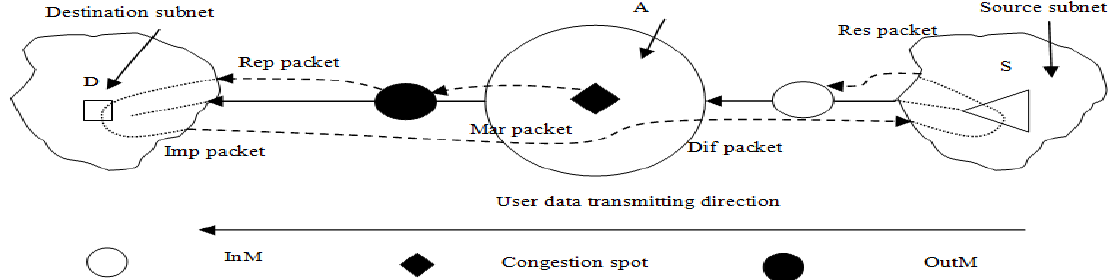
Fig. 2. Congestion control model.